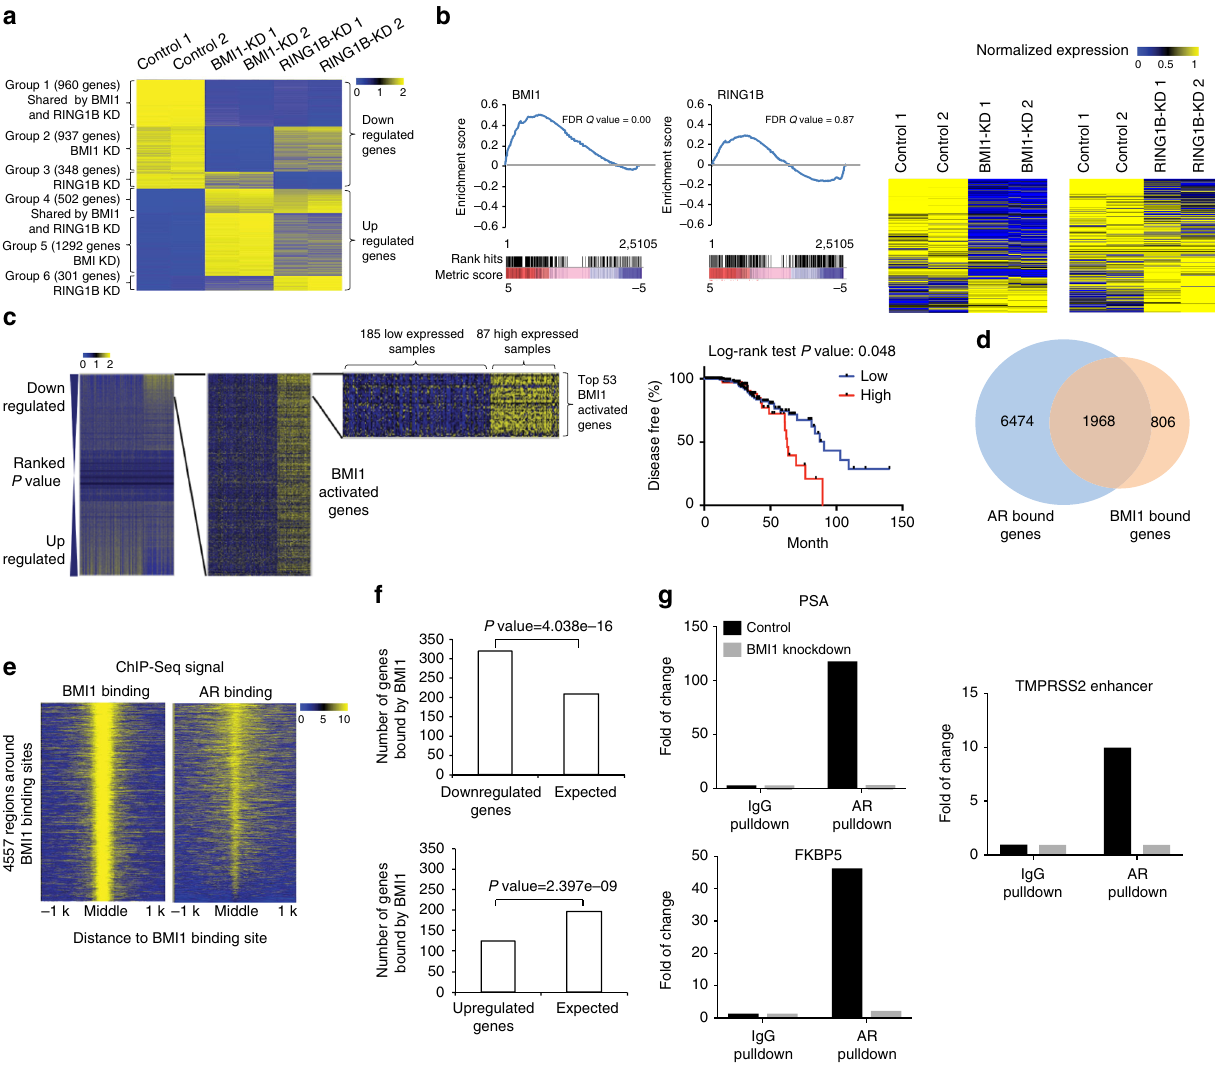
Fig. 4 RNA-seq and ChIP-seq analysis shows that BMI1 regulates AR-signaling pathway independently of PRC1. a Heat maps for expression level of genes down- or upregulated by BMI1 or RING1B knockdown. b GSEA analysis showing enrichment level of AR-induced genes 28 in the genes downregulated by BMI1 or RING1B knockdown, and heat maps for expression level of the AR-induced genes . c Kaplan – Meier (KM) analysis of prostate cancer relapse based on expression level of 53 genes that were most signi fi cantly activated by BMI1 genes. TCGA gene expression data were collected from the Cbioportal database 49,50 . Expression level of each gene in each sample was plotted in the heat map. d Venn diagram showing overlap of genes bound by AR and BMI1 as determined by ChIP-seq data. e Heat map showing the binding density of BMI1 and AR around individual binding sites of BMI1. f Number of genes bound by BMI1 and down- or upregulated by BMI1 knockdown. Number of genes expected by chance is also plotted. P value was calculated by Fisher ’ s exact test. g AR and IgG ChIP were conducted in C4-2 cells transfected with shBMI1 lentivirus or vector virus for 5 days. ChIP-qPCR was conducted using